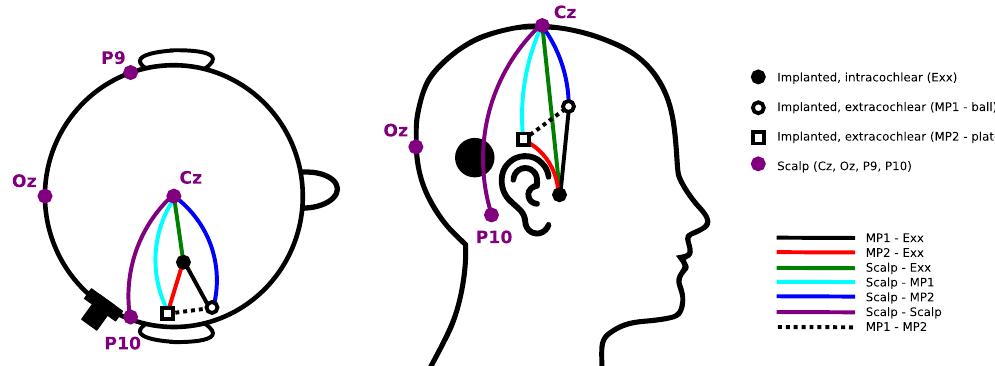
Figure 1. Overview of locations of the electrodes used for recording evoked potentials (not to scale). Implanted electrodes are either located in the electrode array in the cochlea (numbered E01 to E22), or are one of the two extracochlear reference electrodes located in the temporal muscle (MP1 and MP2). Scalp electrodes are placed in central (Cz), occipital (Oz) and left/right mastoid (P9/P10) sites. In this instance, the percutaneous connector is shown on the right side of the head. The different recording dipoles between which EEG signals are measured are indicated with color-coded lines between electrodes. This color-coding scheme is used for indicating recording configurations of evoked potentials in subsequent